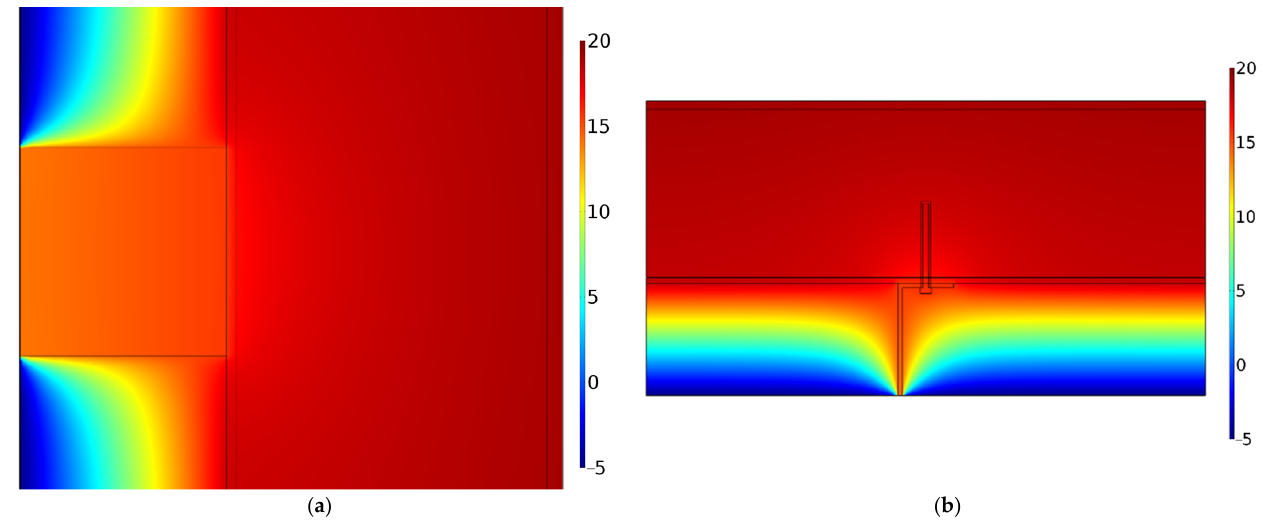
Figure 4. Temperature distribution (°C) in 2D vertical ( a ) and horizontal ( b ) sections.